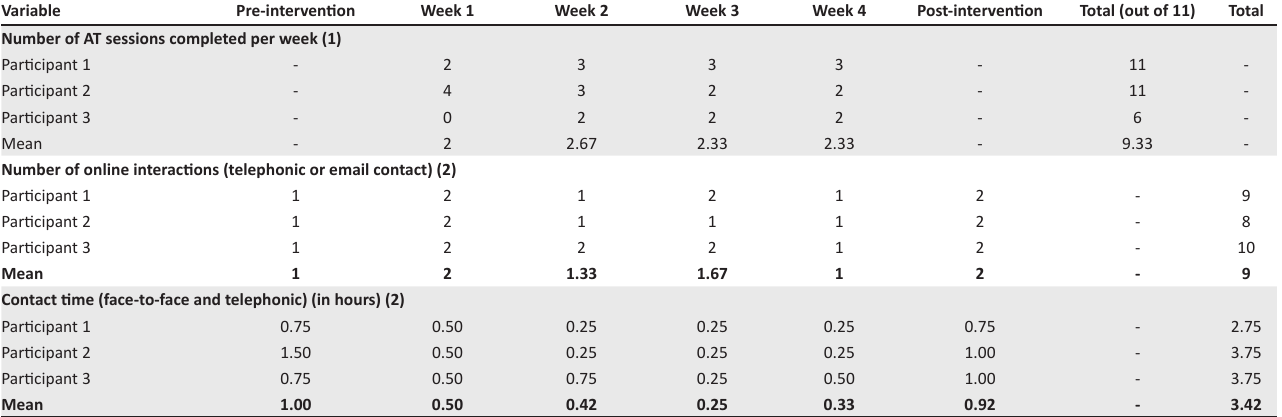
TABLE 2: Compliance